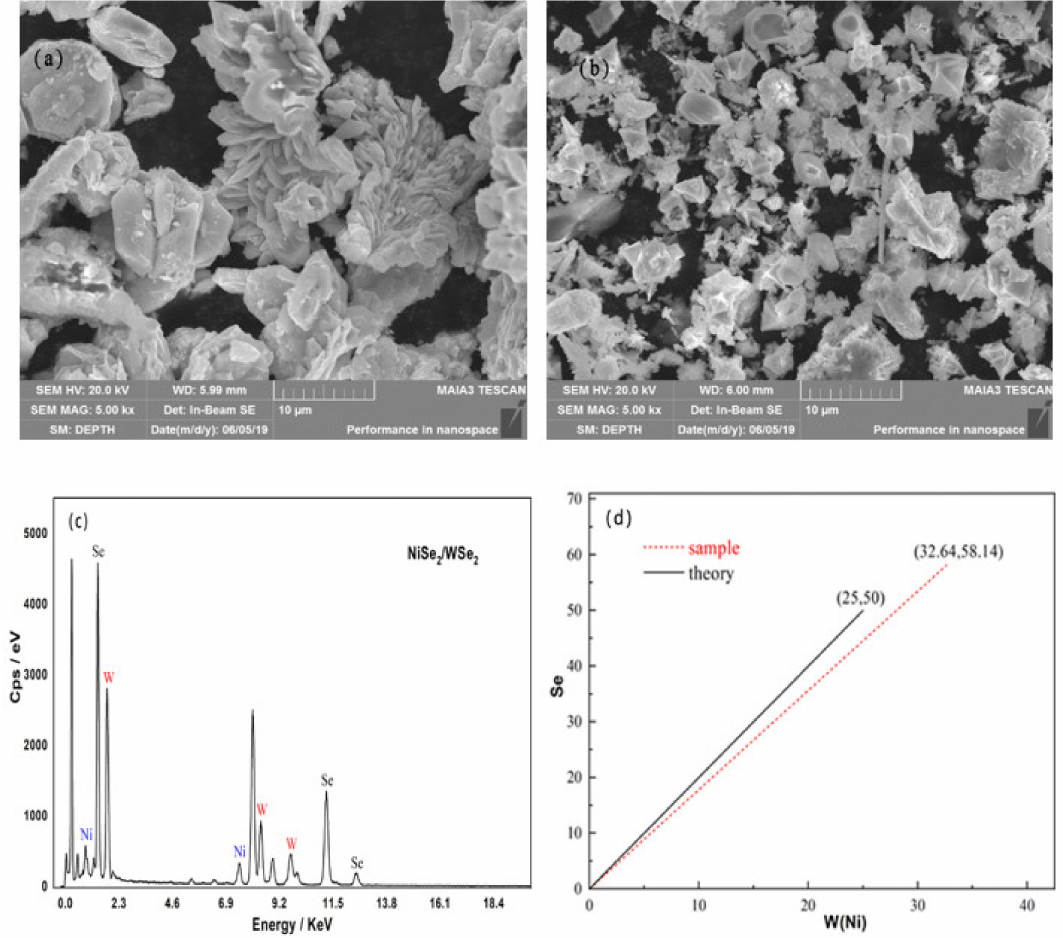
Figure 5. SEM of ( a ) WSe 2 ; ( b ) NiSe 2 / WSe 2 ; ( c ) EDS of NiSe 2 / WSe 2 ; ( d ) Atom ratio of NiSe 2 / WSe